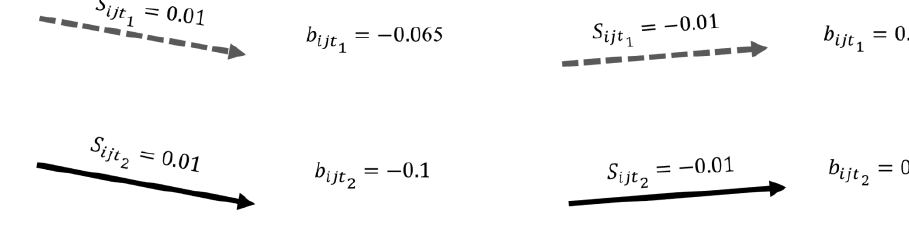
Figure 3. Example of the calculation of 𝑏 𝑖𝑗𝑡 with Criterion 2.